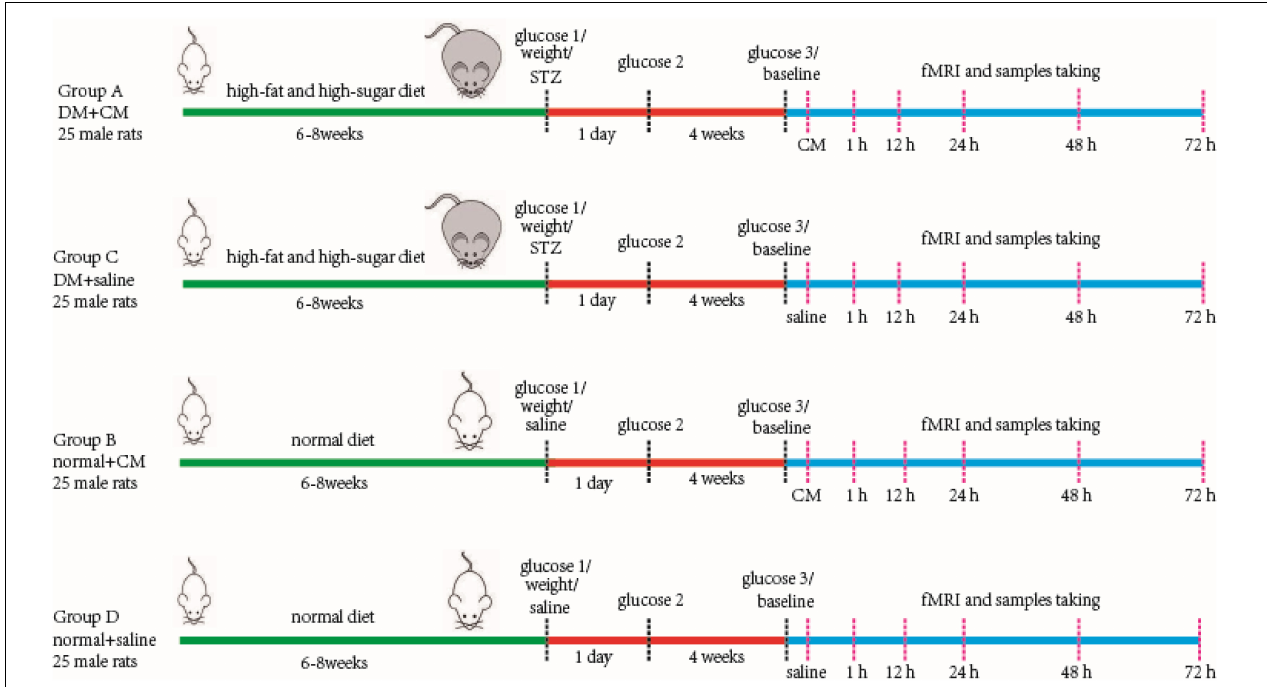
FIGURE 1 | Main procedure of experiment workflow. Four groups of rats are performed as in the figure. Two random glucose test results at or above 16.7 mmol/L were the DM model criteria. Baseline scanning is prior to CM or saline tail injection. The serum and kidney samples were store at − 80 ◦ C after collecting for further study. CM, contrast media; DM, diabetic mellitus; STZ, streptozocin.